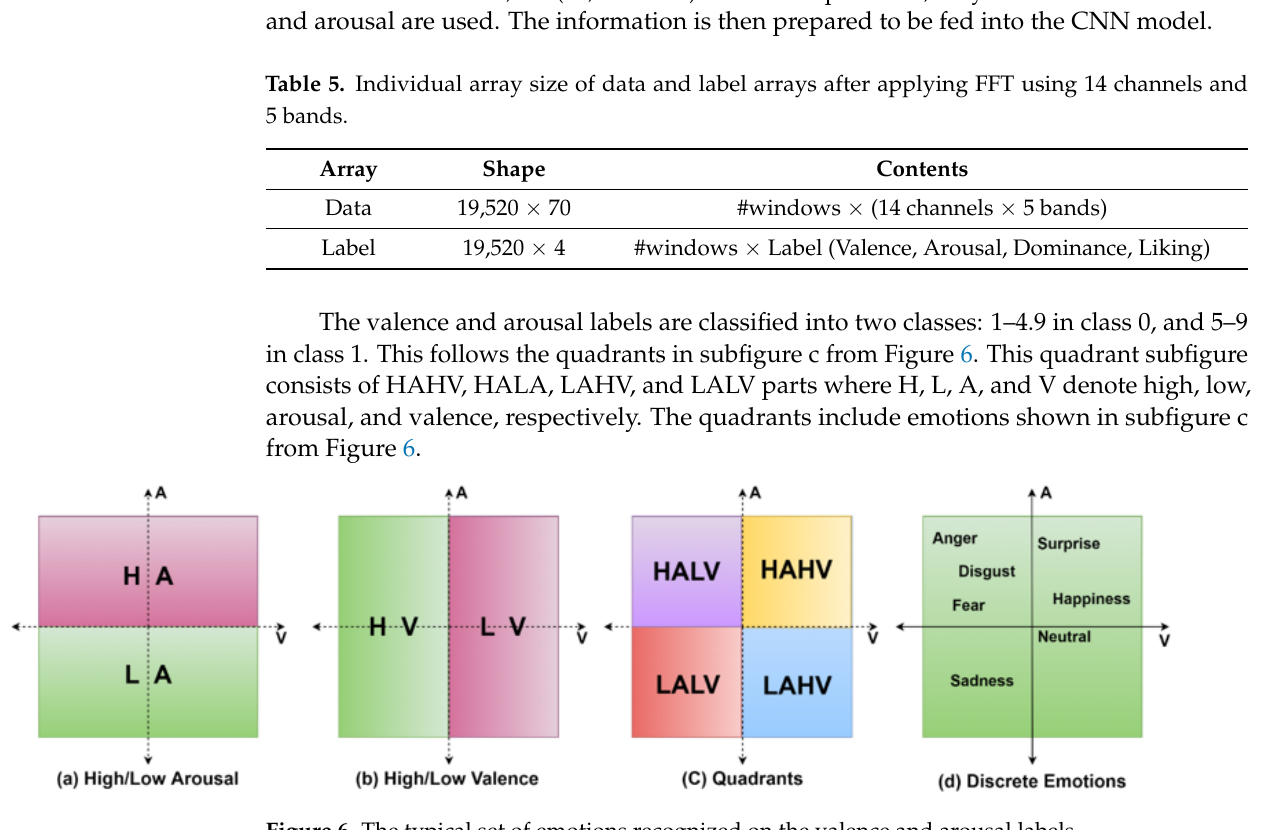
Figure 6. The typical set of emotions recognized on the valence and arousal labels.